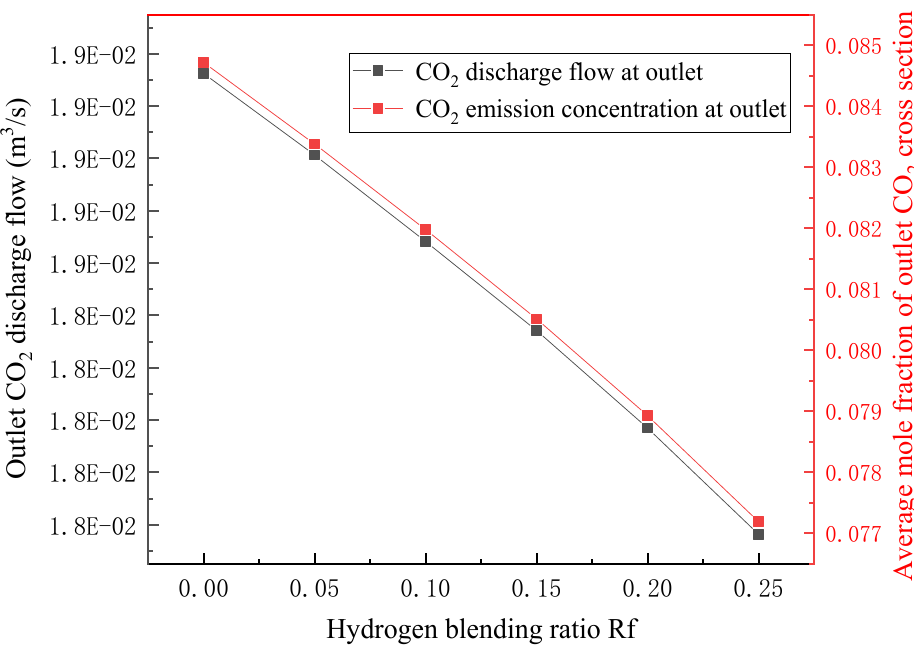
Figure 11. Discharge flow of outlet flue gas.